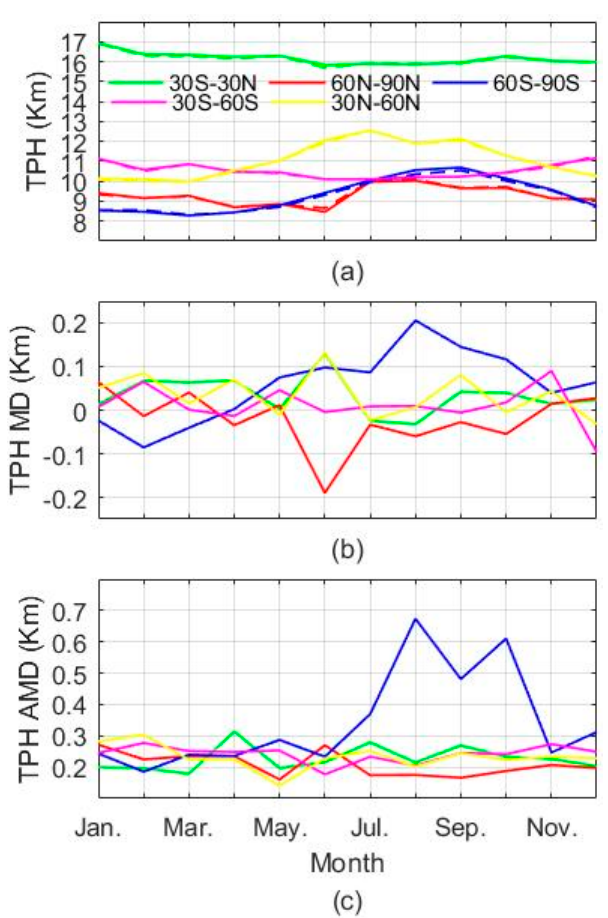
Figure 5. Panel ( a ) indicates the annual cycle mean tropopause height (TPH) retrieved from four years of collocated FY-3C and COSMIC data. Dashed lines are for COSMIC results and solid lines are for FY-3C results. Panel ( b ) and panel ( c ) show the mean and absolute deviation.